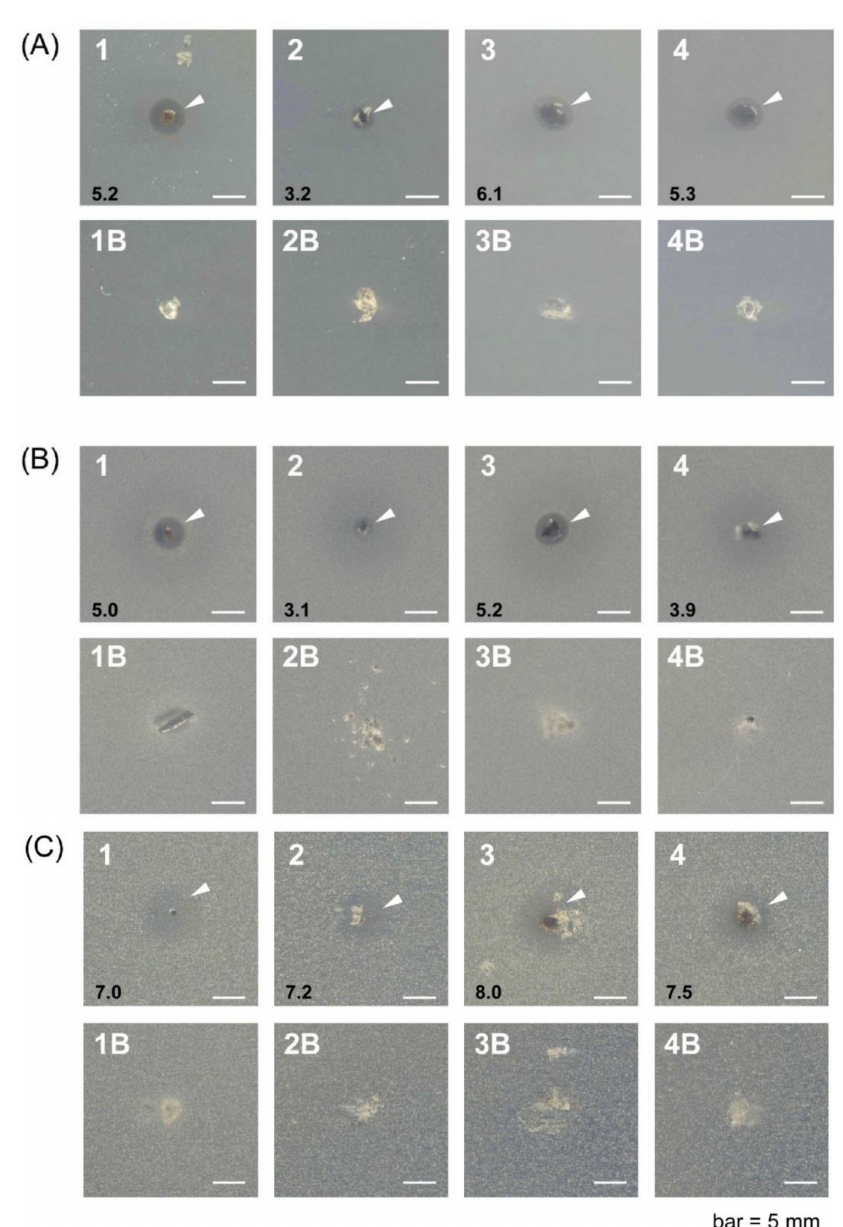
Figure 9. Antimicrobial activities of silver nanocomposite hydrogel (1–4) and native hydrogel (1B–4B) against Escherichia coli ( A ), Bacillus subtilis ( B ), and Saccharomyces cerevisiae ( C ). (Hydrogels: 1, H5-EBA; 2, PHE-Nip-EBA; 3, PHE-Nip-PEG; 4, AVA-Nip-PEG). Arrow heads indicate inhibitory zones, and black numbers mean diameter of inhibitory zone